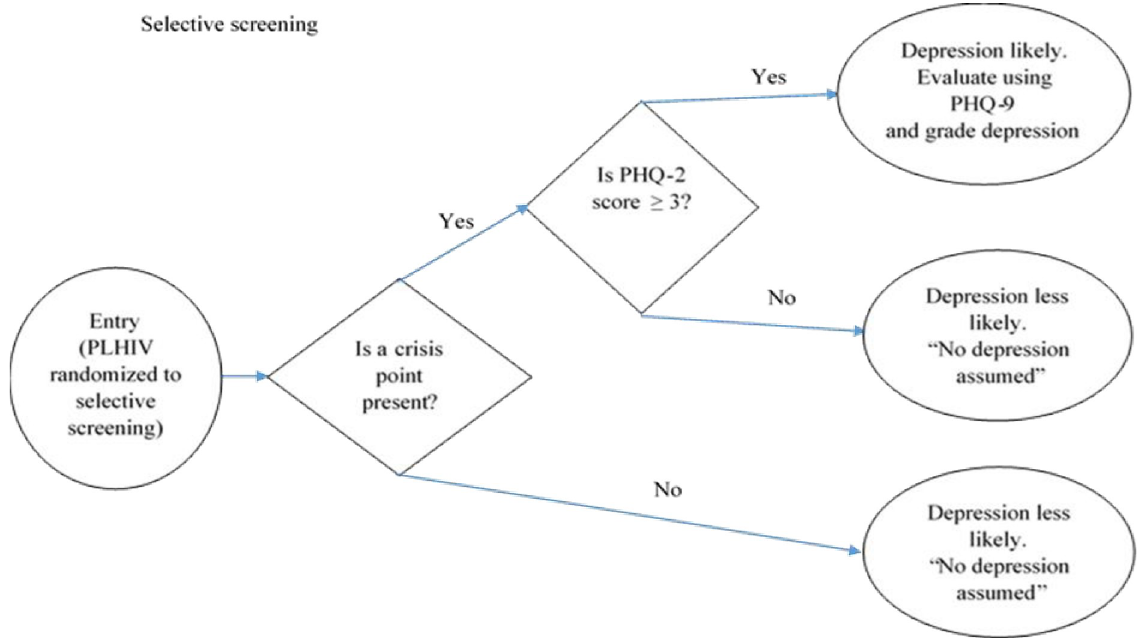
Fig 2. An illustration of selective screening strategy for depression among